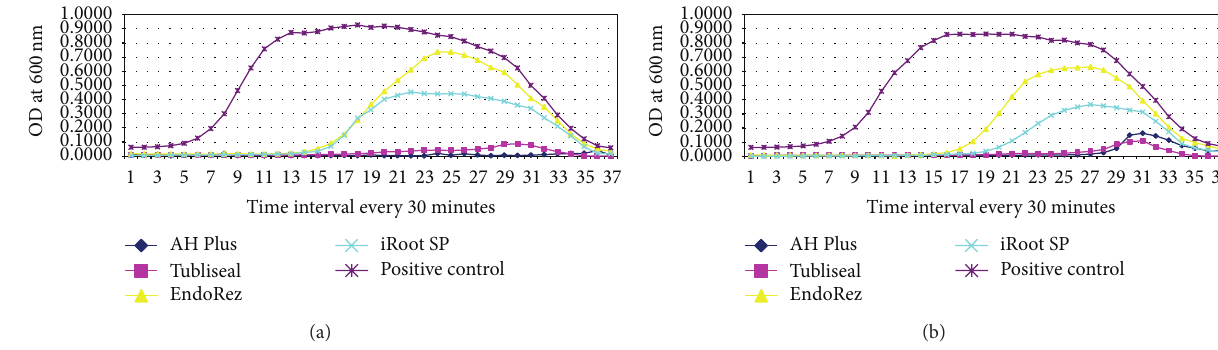
Figure 4: Line graph showing microbial growth curve of S. aureus in (a) presence of tested sealers, A well and (b) absence of tested sealers, B well of the four different endodontic sealers. 𝑥 -axis depicts time intervals at which the mean OD was recorded (at every 30mins) and 𝑦 -axis depicts mean corrected OD recorded at 600 nm. Each point on the growth curve is the average of the OD measured in 12